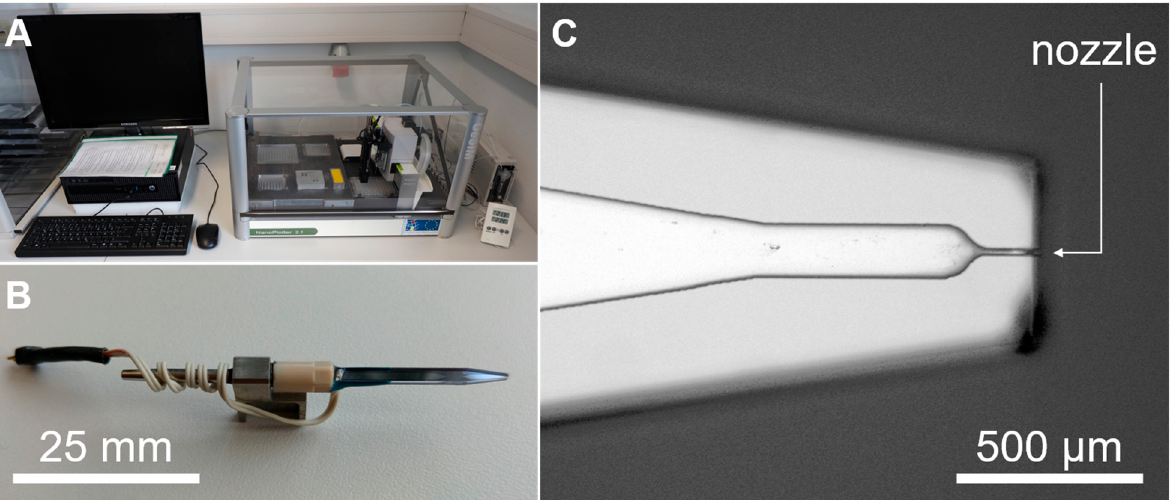
Figure 1. ( A ) Nanoplotter 2.1 device (GeSiM mbH, Radeberg, Germany). ( B ) Piezoelectric DOD inkjet printhead model “Pico-Tip J” for Nanoplotter 2.1 device (GeSiM mbH, Radeberg, Germany). ( C ) Microscopic picture of the tip of the printhead with the nozzle (microscopic imaging system: BX51, Olympus K.K., Tokyo, Japan).